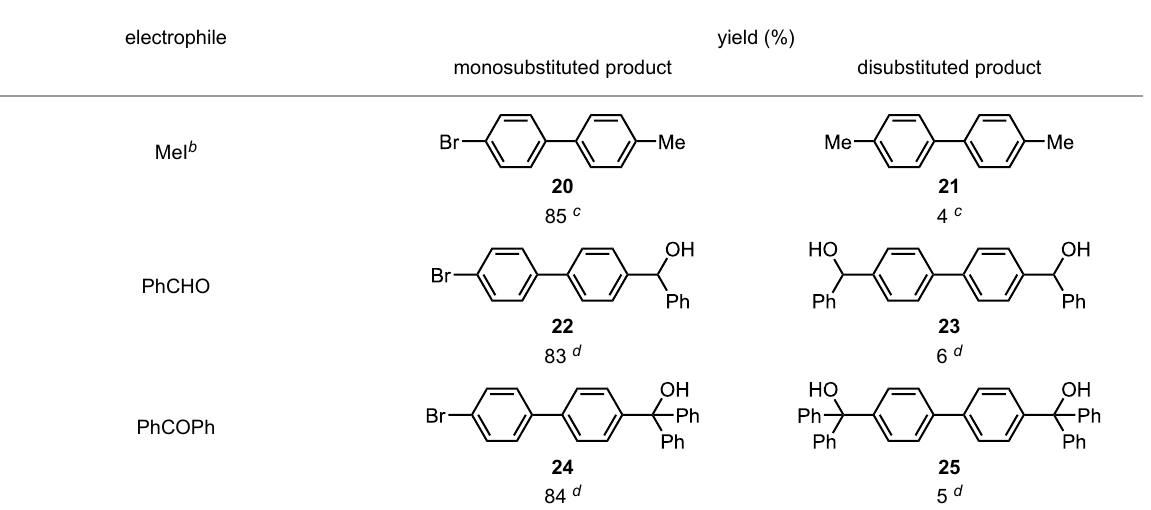
Table 6: Br-Li exchange reaction of 4,4′-dibromobiphenyl ( 17 ) followed by the reaction with an electrophile using the microflow system. a